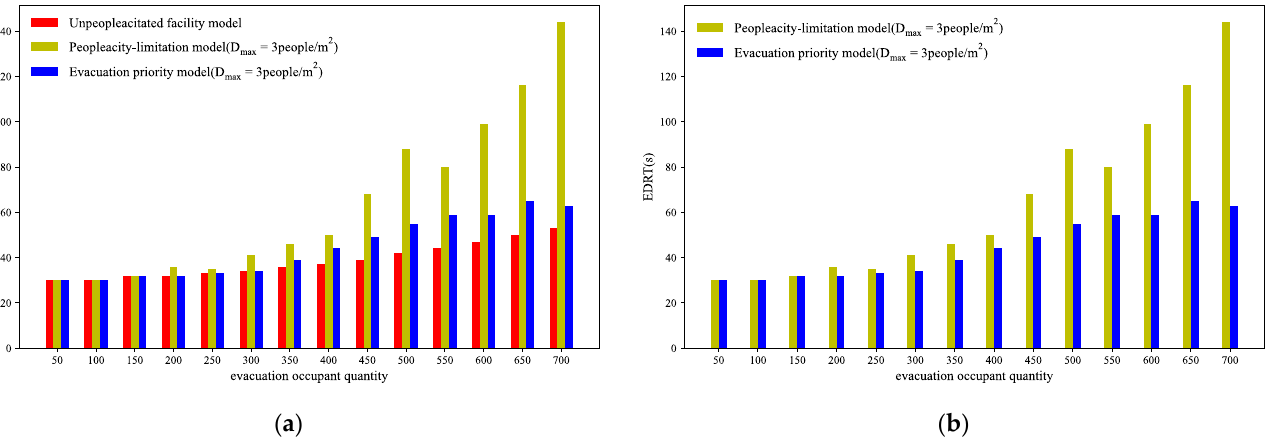
Figure 17. EDRT comparison of evacuation simulations with different evacuation models. ( a ) EDRT for evacuation simulation of three types of models; ( b ) Comparison of EDRT between path capacity constraints and adding evacuees’ priority based on the path capacity